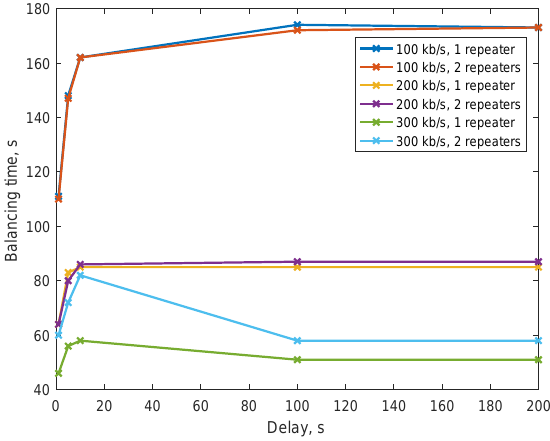
Figure 18. Balancing of two streams in a network with bottlenecks.